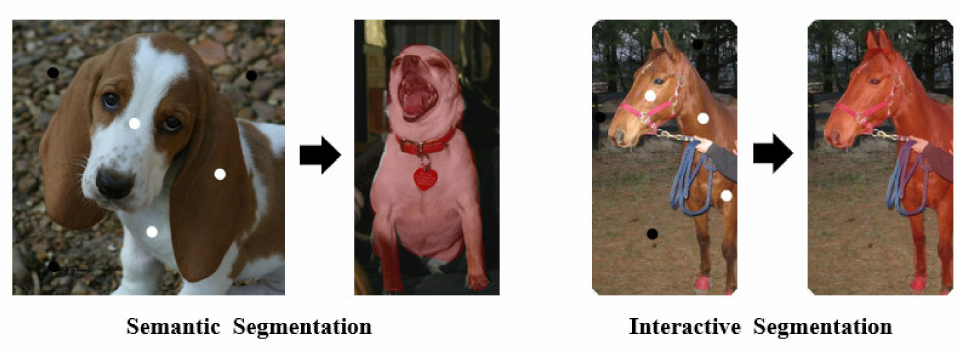
Figure 2. Our few-shot image segmentation subsumes semantic and interactive. It is worth noting that interactive-based cannot propagate annotations across di ff erent images. Our proposed method can be used in both